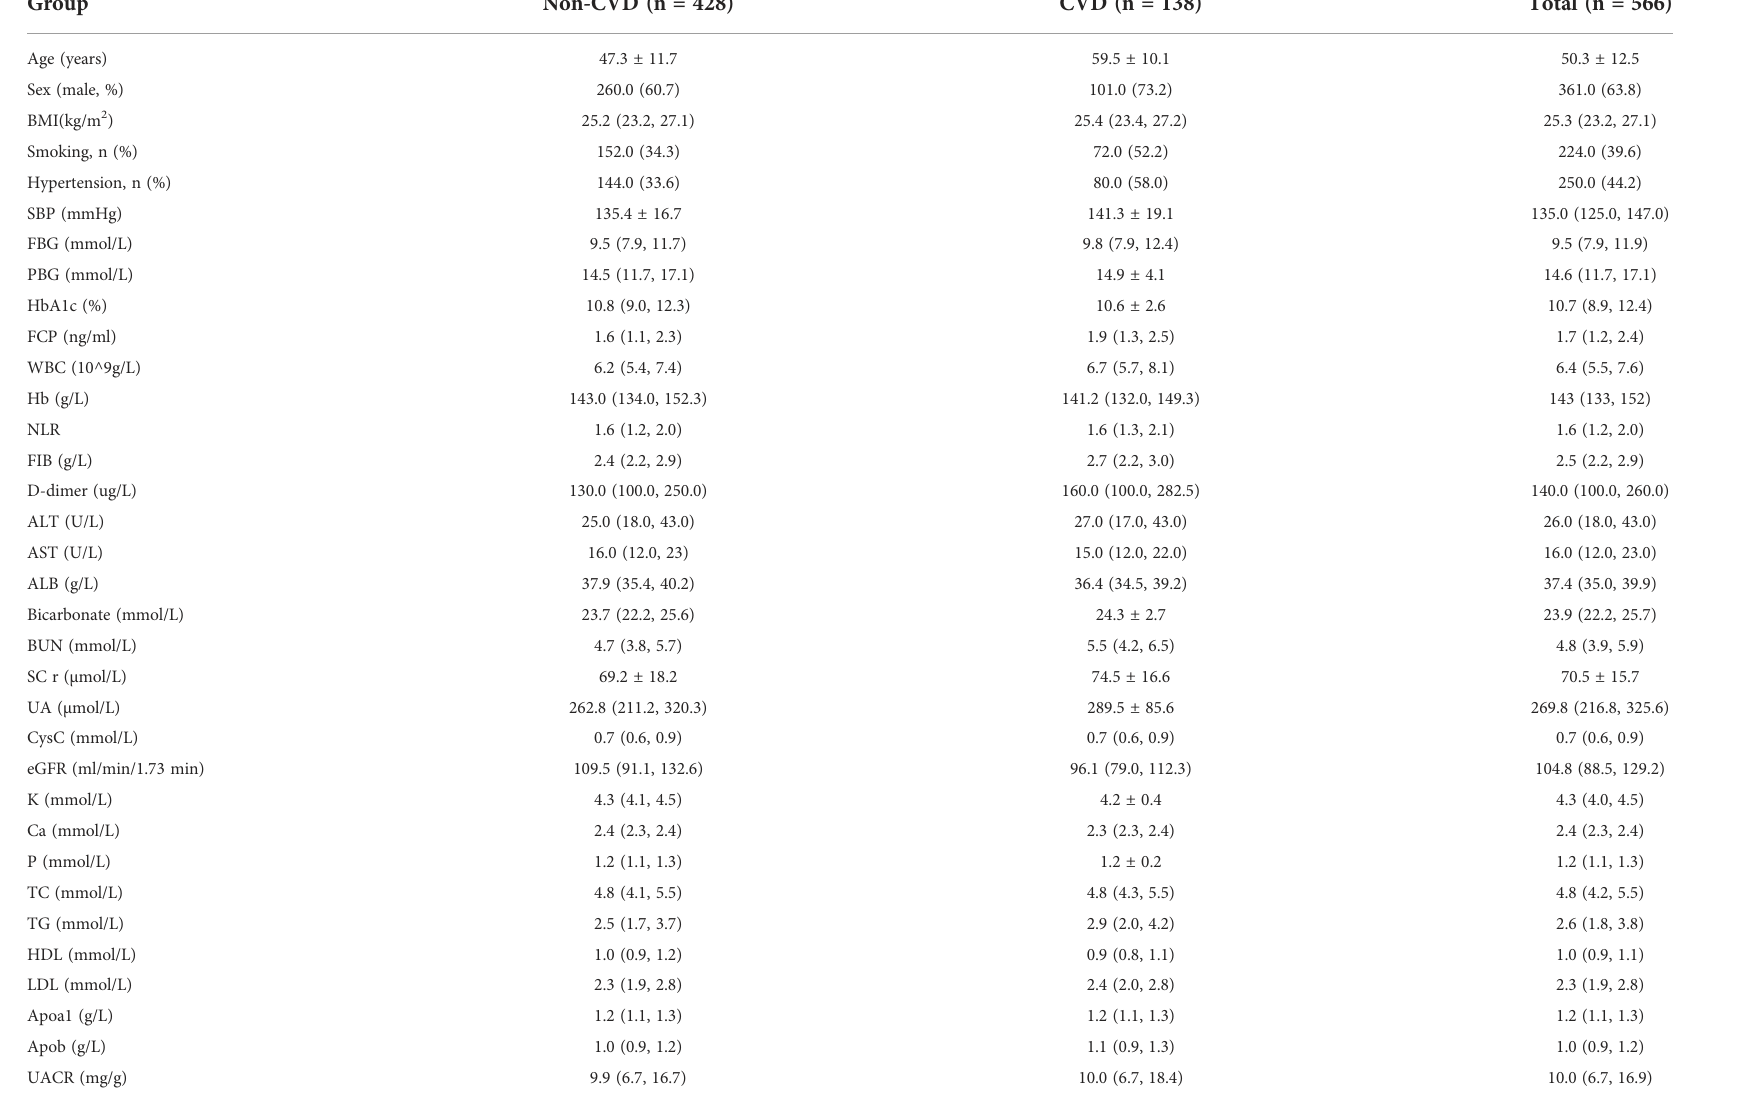
TABLE 1 Demographic and clinical characteristics of patients with Non-CVD and